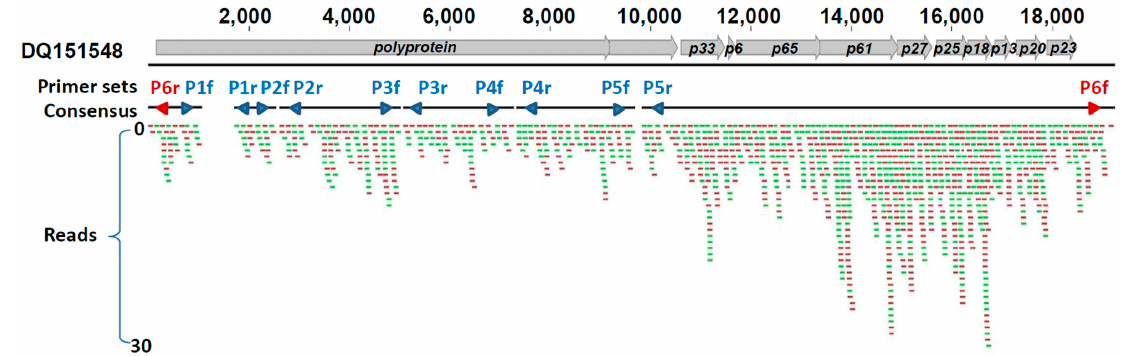
Figure 2. Illumina HiSeq reads coverage by mapping cDNA from Citrus tristeza virus (CTV)-positive Diaphorina citri onto a reference CTV isolate DQ151548. All reads are 100 bp long, obtained from sequences retrieved from Diaphorina citri collected in Guangdong, China. The numbers on the top are nucleotide genome length (nt), and the arrows and letters represent Sanger-sequenced amplicons from 5 PCR primer sets (P1–P5) used to span and bridge the genome, and one primer set (P6) used to suggest a linear structure for CTV genome. “Reads” area span forward reading frames (in red) and reversed reading frames (in green).